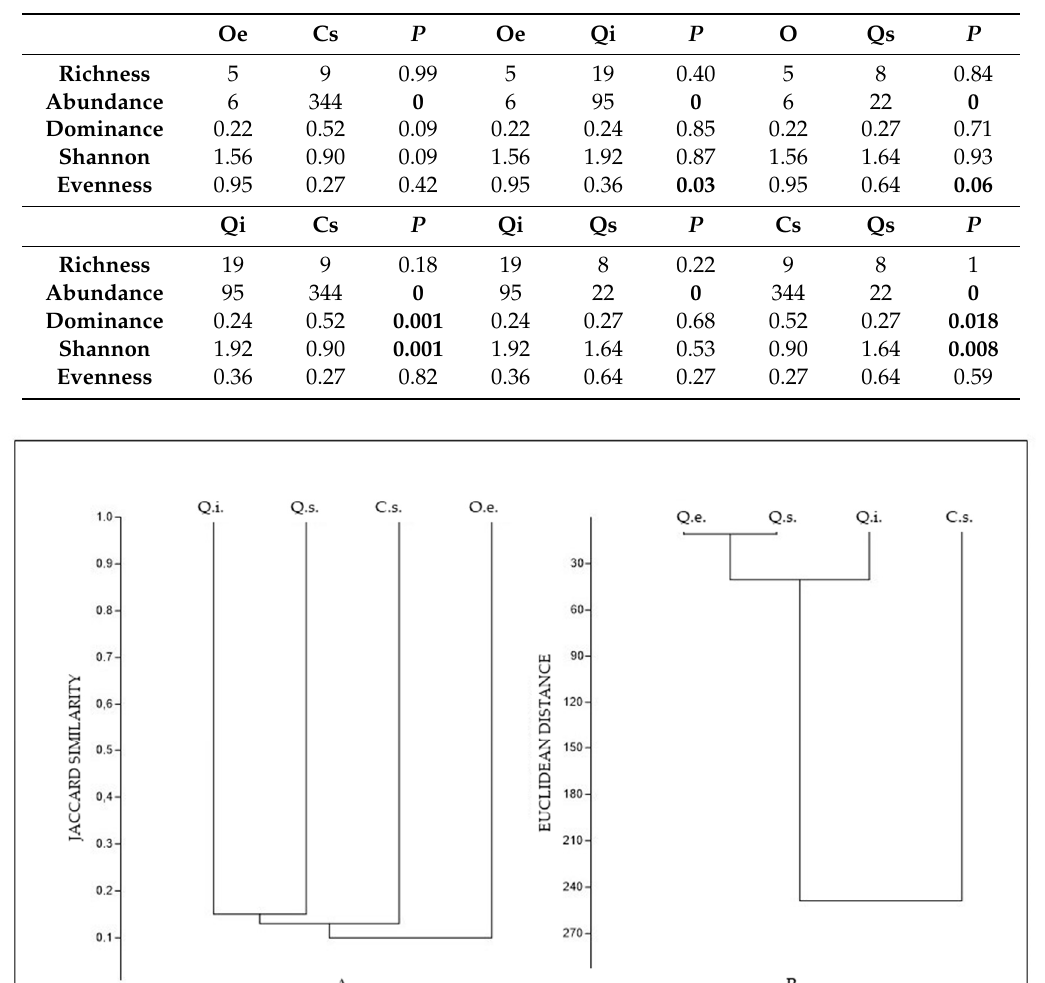
Table 5. Richness (species number), abundance (specimen number), dominance (Simpson’s index), diversity (Shannon–Wiener H’), evenness indices for saproxylic communities linked to each tree species (Cs: C. siliqua ; Oe: O. europaea ; Qi: Q. ilex ; Qs: Q. suber ), and paired comparisons between them. p = bootstrapping comparisons. Values with statistical significance are highlighted in bold type.